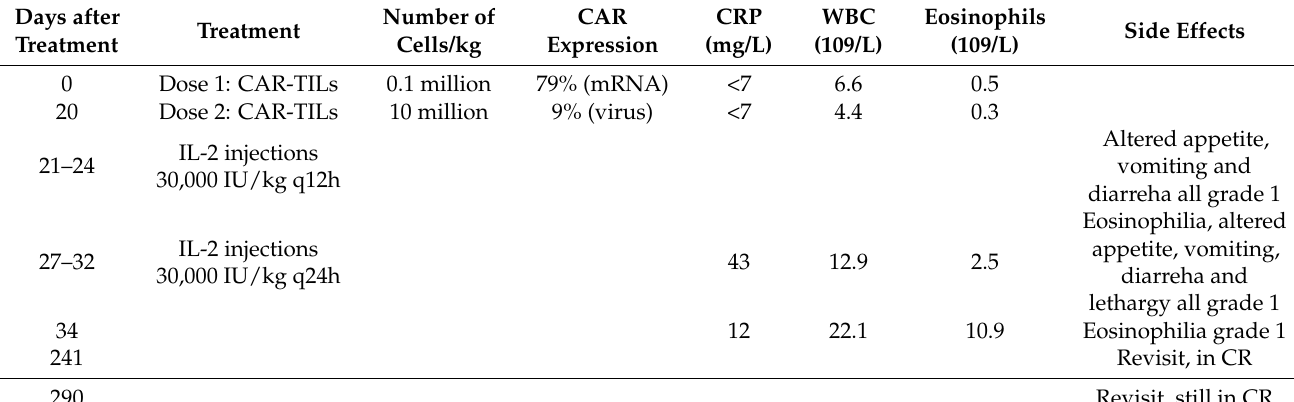
Table 2. Clinical responses to CAR-TIL treatment of Dog